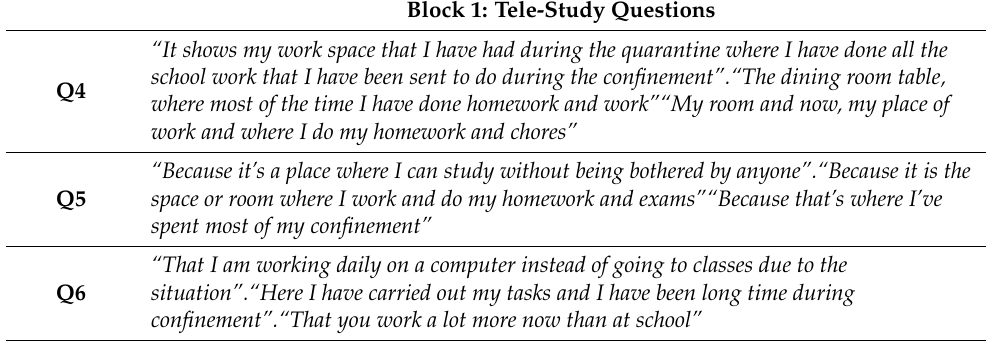
Table 6. Selection of verbatims from answers to each question about the photographs. Block 1: Tele-Study